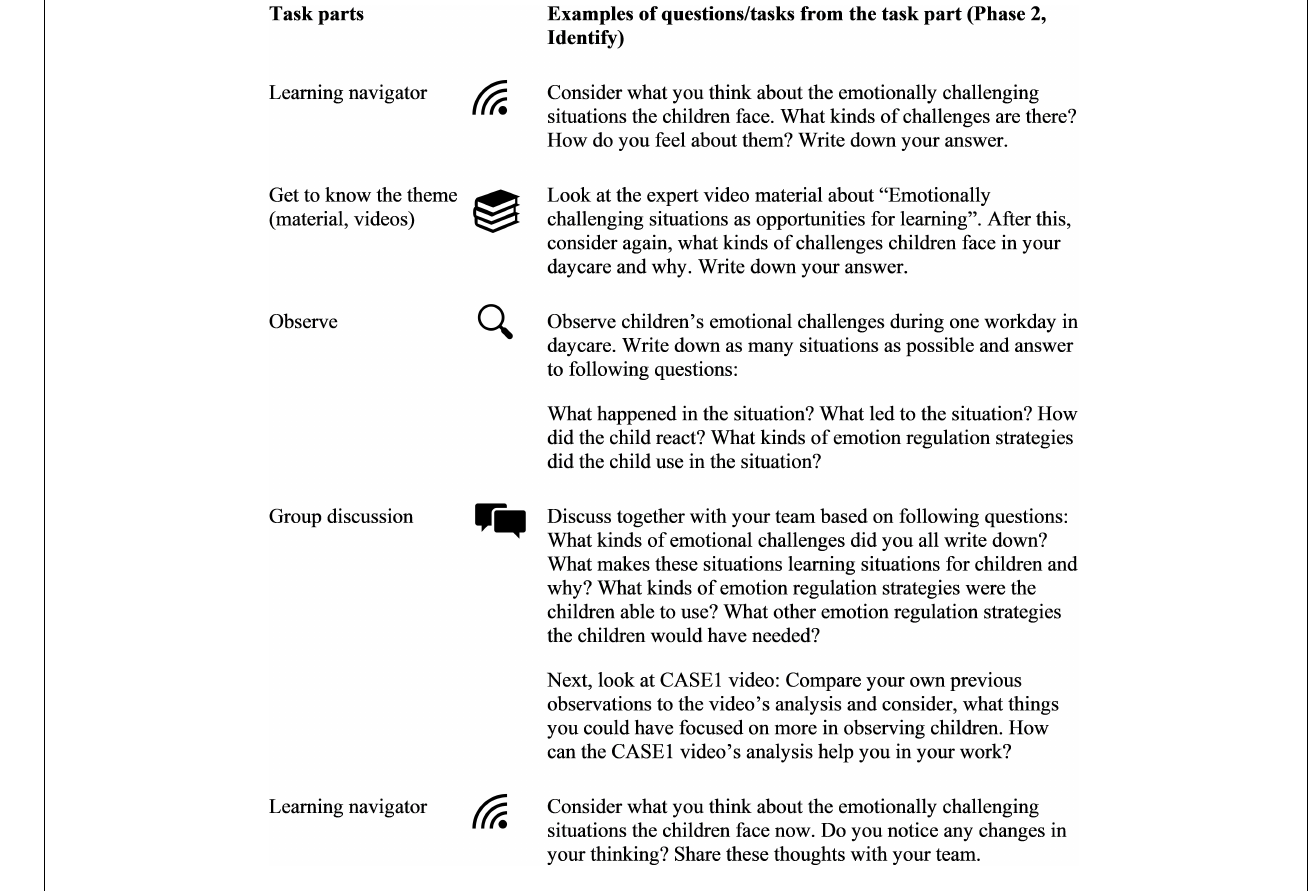
FIGURE 3 | An example of the contents of the task parts from the Phase 2,